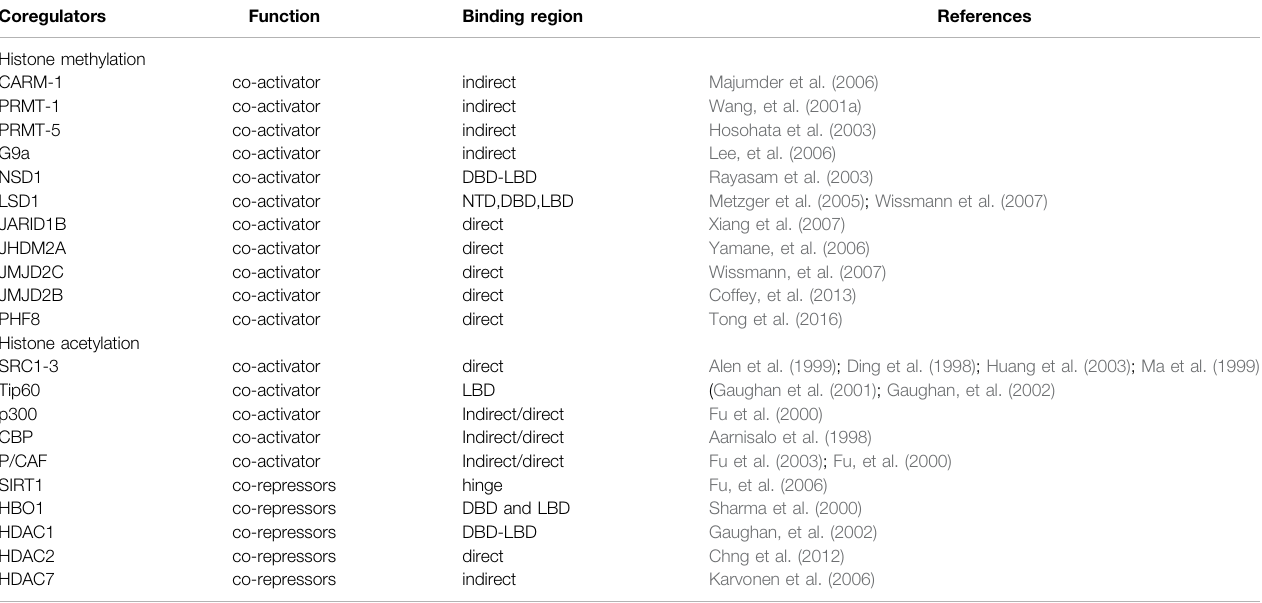
TABLE 1 | An overview of coregulators that modulate AR